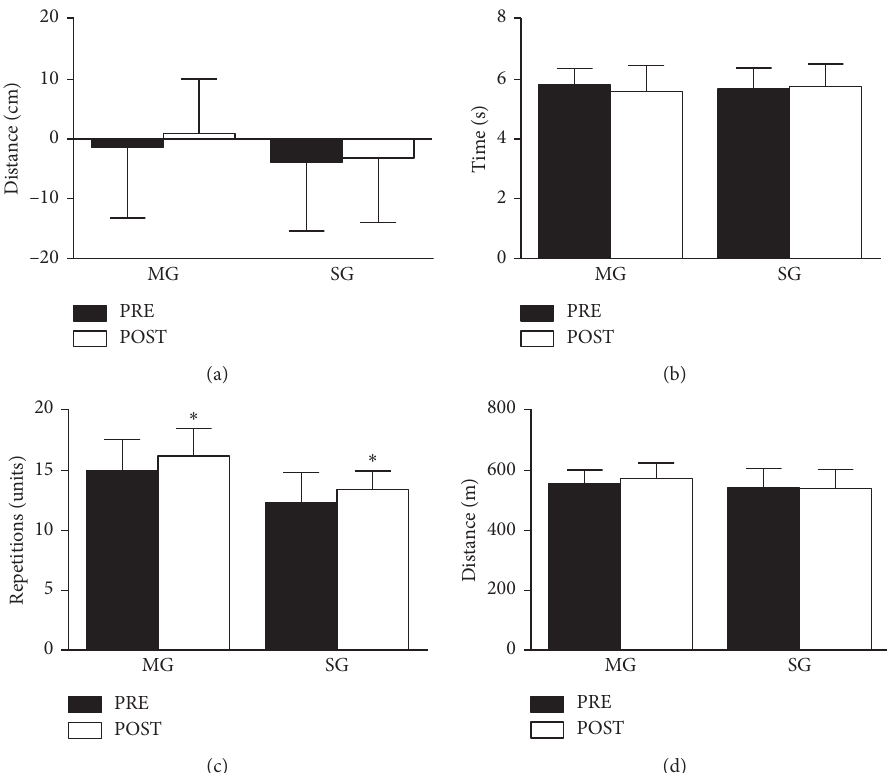
Figure 3: Functional capacity tests for multicomponent and strength groups at pretraining and posttraining. ∗ Main time effect and p � 0 . 02. (a) Sit and reach test. (b) 8 foot up and go test. (c) 30s chair stand test. (d)